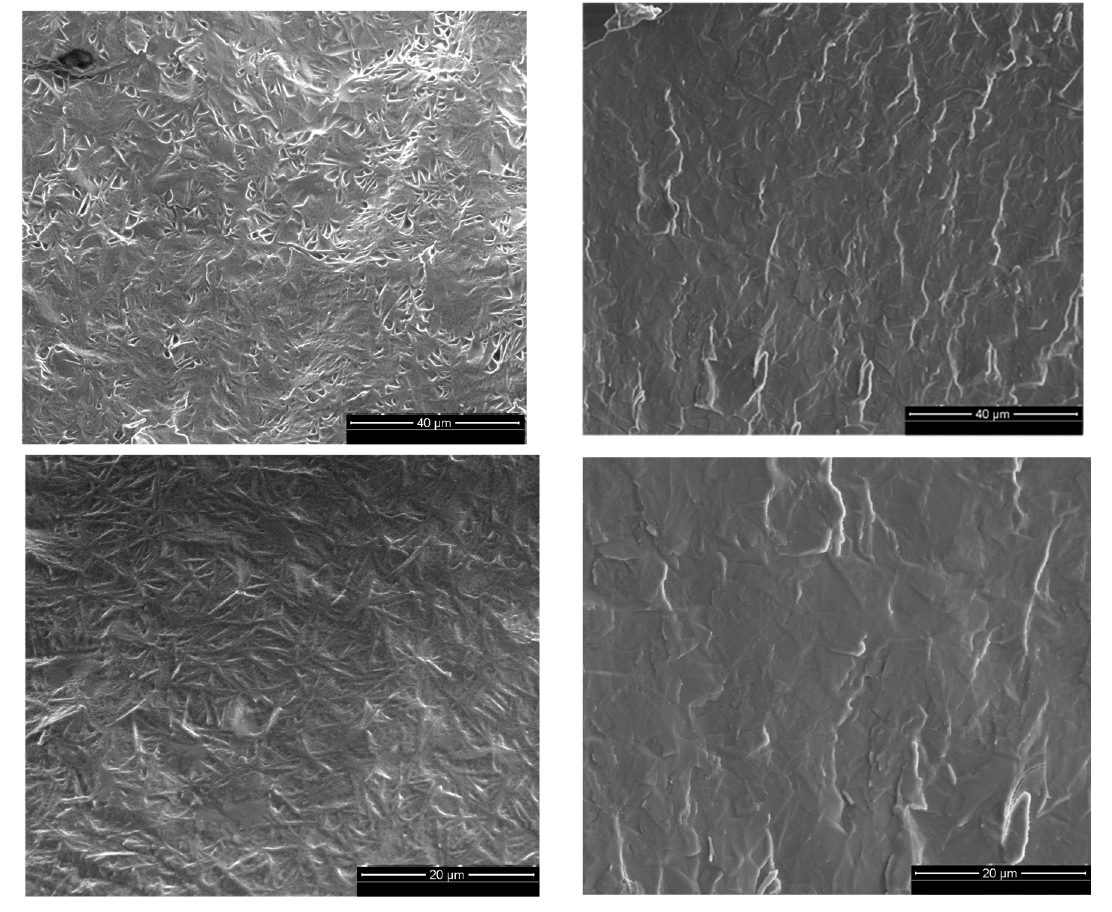
Figure 5. Cryo-SEM micrographs of 6% “intact” ( on the left ) and pre-sheared gels ( on the right ). Micrographs at different magnifications: 40 and 20 µm (from top to the bottom ).